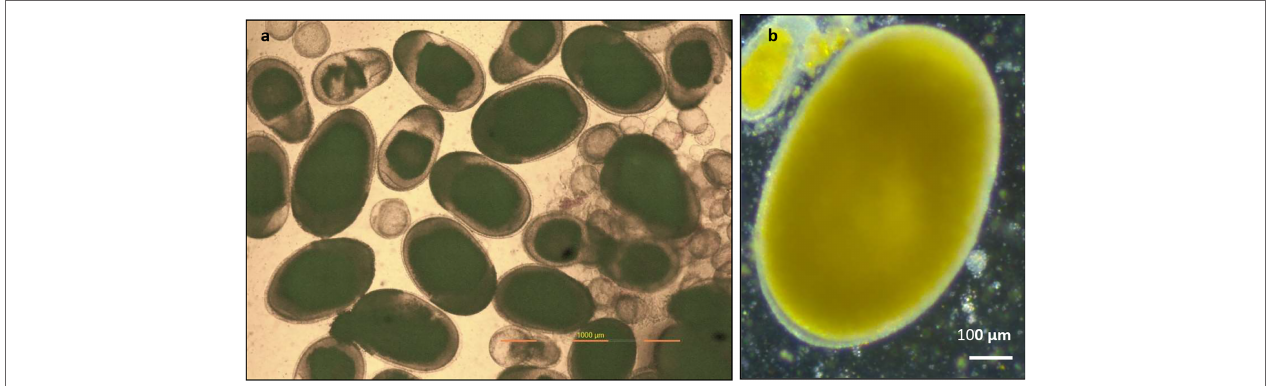
FIGURE 3 | Biopsy samples of ovary of P. maculatus (A) sample from a female ovary indicating developing oocytes (small spherical), immature oocytes (small oval), and ripe oocytes (large oval) observed under a compound microscope. (B) image of a ripe oocyte with clear zona radiata and cytoplasm filled with yolk granules observed under a steriozoom